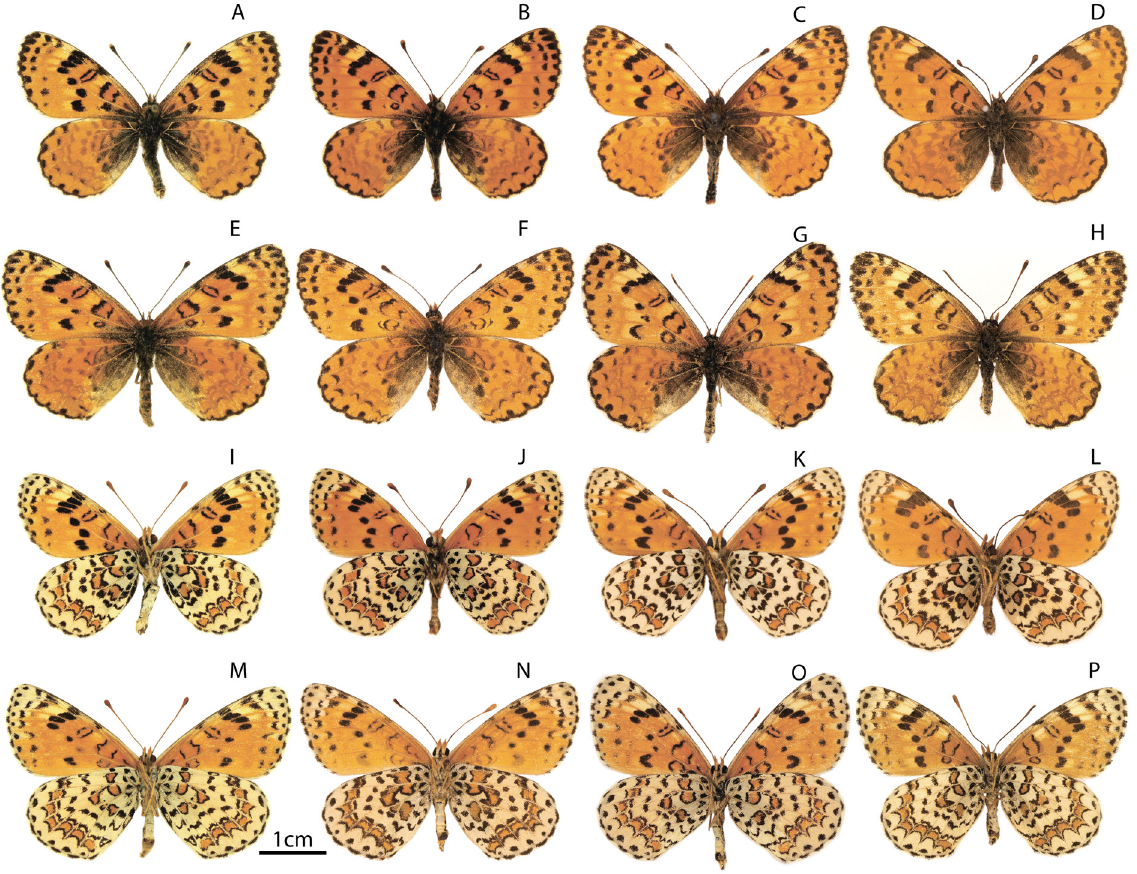
Fig. 9. Adults of Melitaea timandra timandra Coutsis & van Oorschot, 2014. A – H . UPS. I – P .